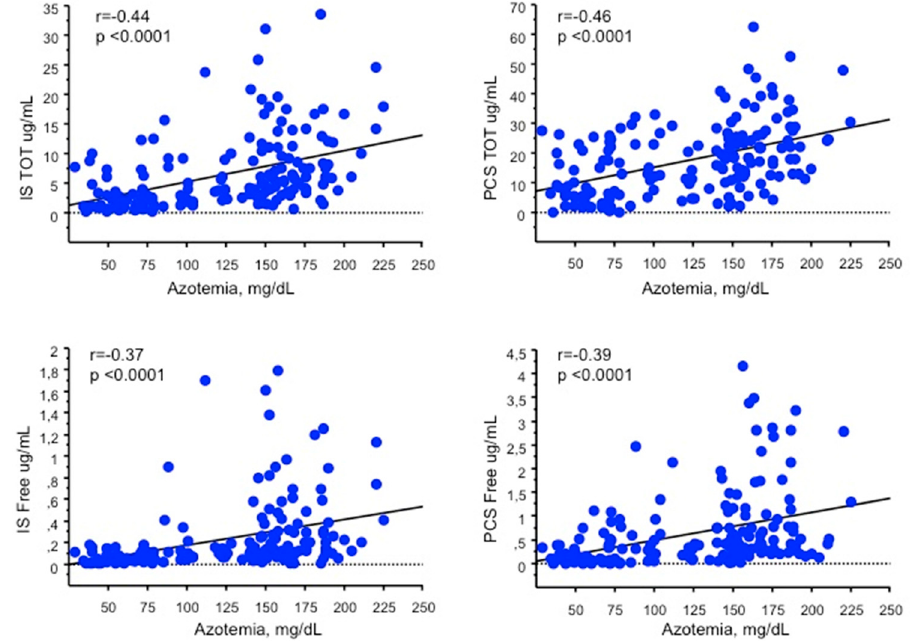
Figure 6. Correlations between the serum levels of ( A ) total indoxyl sulfate (IS TOT), ( B ) total p-cresyl sulfate (PCS TOT), ( C ) free indoxyl sulfate (IS free), ( D ) free p-cresyl sulfate (PCS free) and azotemia.